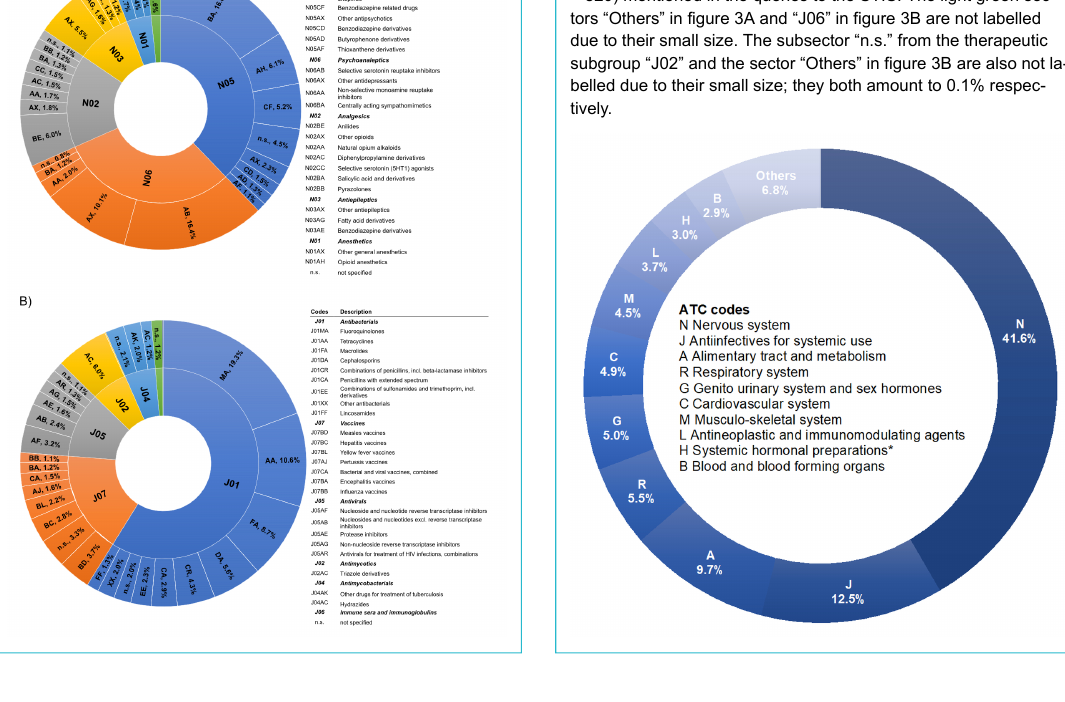
Figure S1: Exposures to medications during singleton pregnan- cies with available follow-up documentation, depicted by anatomi- cal main groups (n = 6583). *excluding sex hormones and insulins